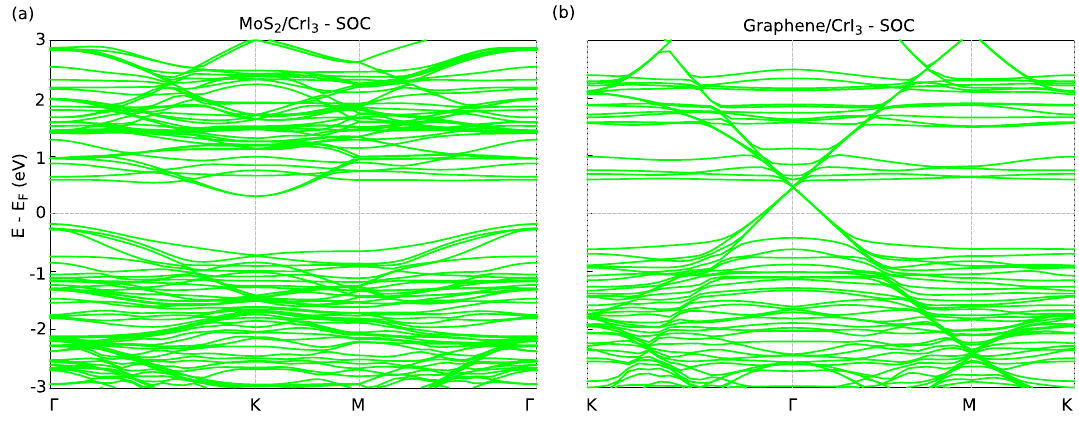
Figure 6. Spin-orbit coupled (SOC) bandstructure of ( a ) 2:1 MS/CrI 3 ( b ) 3:1 G/CrI 3